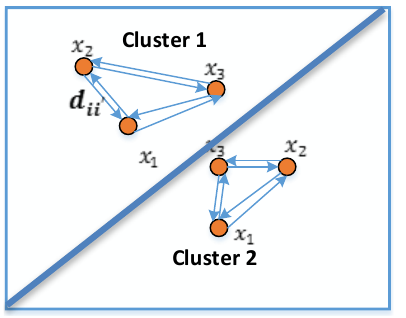
Figure 3. Sensor nodes in a cluster 15